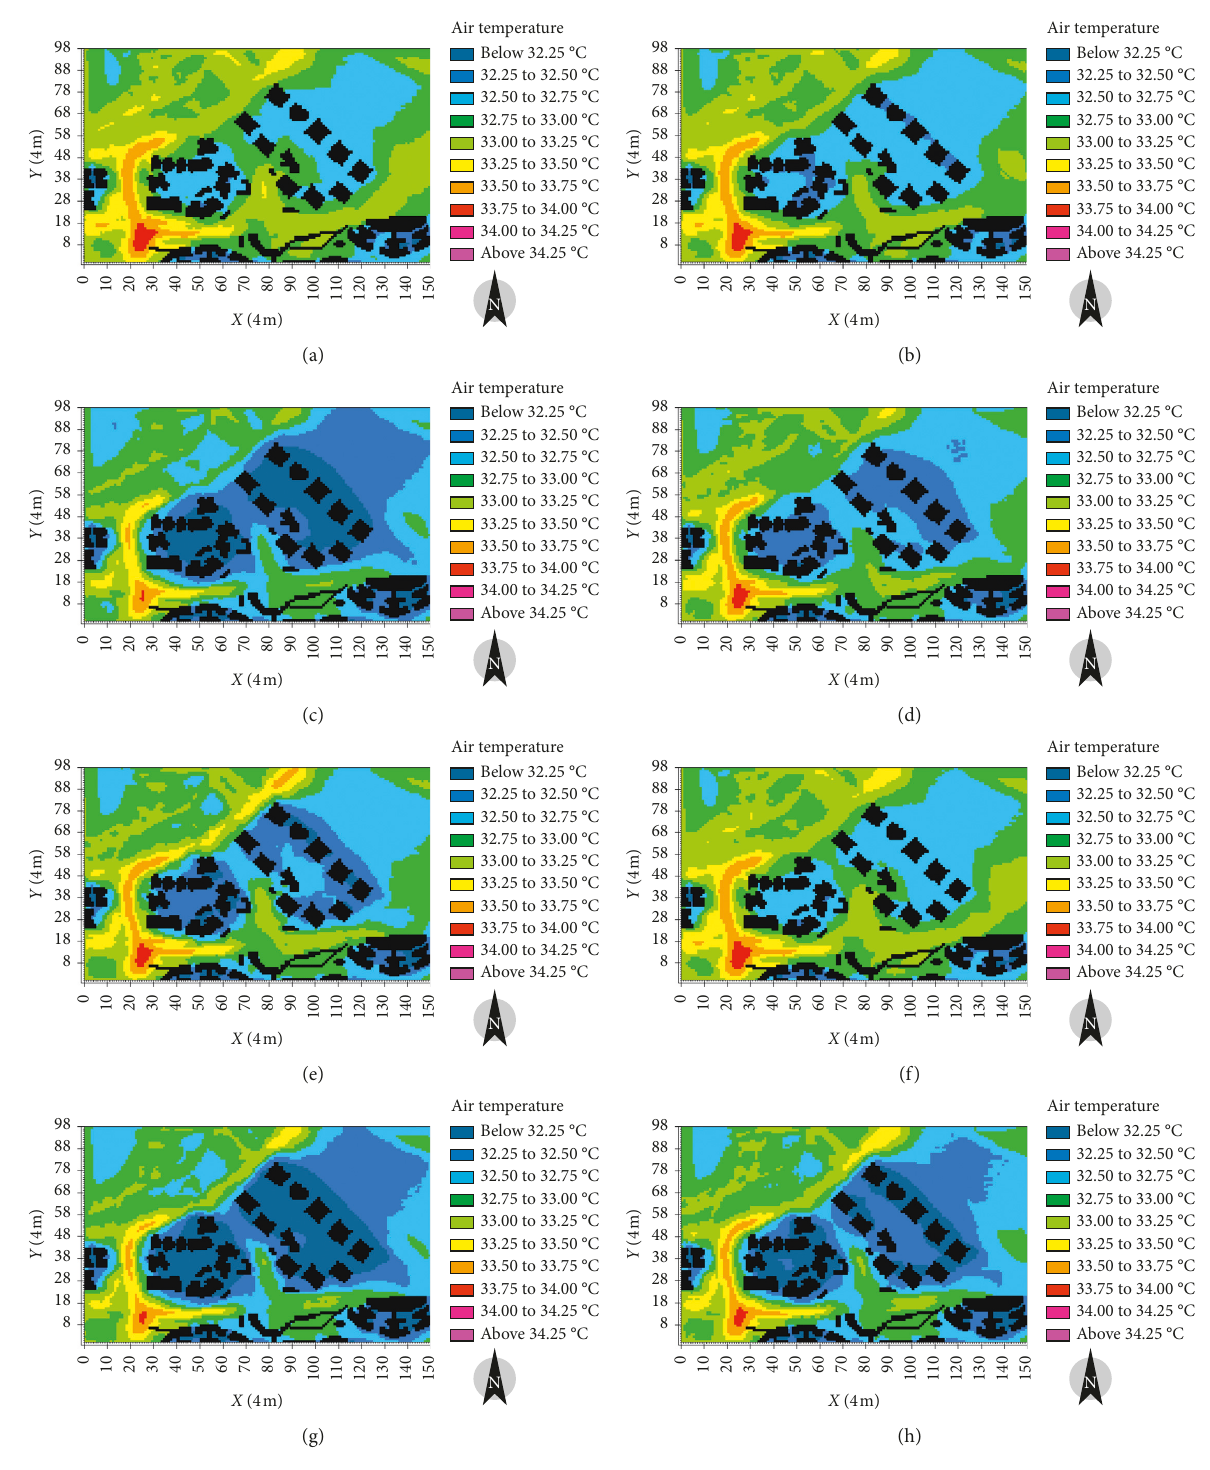
Figure 7: Simulated air temperature for all design scenarios. (a) Base case. (b) Scenario 1 (wooden boards). (c) Scenario 2 (light-color granite). (d) Scenario 3 (grass surface). (e) Scenario 4 (more trees). (f) Scenario 5 (more water bodies). (g) Scenario 6 (light-color granite +more trees). (h) Scenario 7 (grass surface+more